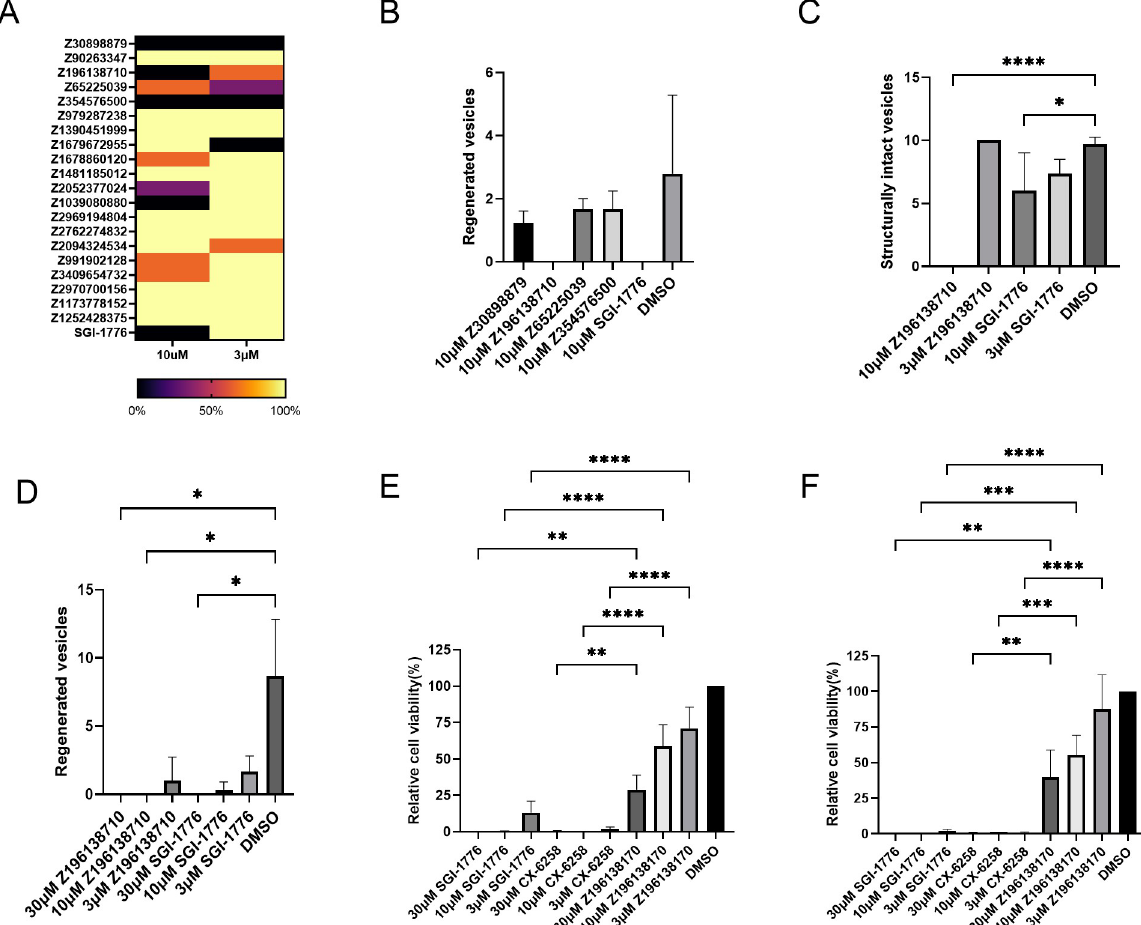
Fig 7. Effects of Pim inhibitors on Echinococcus larvae and human cells. (A) Heat map showing the effects of 20 in silico screen compounds on MV. Different concentrations (indicated below) of each compound (indicated to the left) were incubated in vitro with MV for 28 d and structural integrity was assessed. Colour-code indicating percentages of surviving vesicles is indicated below. (B) Effects of four in silico screen compounds on MV production from PC. 10 μ M of each compound (indicated below) were incubated for 21 d with PC in vitro and the production of MV was assessed. For comparison, SGI-1776 was tested at 10 μ M. Error bars represent standard deviation. Kruskal-Wallis test followed by Dunn’s multiple comparison test was used for comparisons with the control (DMSO) group. (C) Effects of Z196138710 and SGI-1776 on MV. Both compounds were tested at different concentrations (shown below) on MV in vitro . Structural integrity was measured after 28 d. Error bar represents standard deviation. One was ANOVA followed by Dunnet’s multiple comparison test was used in comparisons with control (DMSO) group. p values less than 0.0001 are summarized with ���� and p values less than 0.0332 are summarized with � . (D) Effects of Z196138710 and SGI-1776 on the in vitro formation of MV from PC. Both inhibitors were incubated at different concentrations (indicated below) for 21 d with PC and the formation of mature MV was measured. Error bar represents standard deviation. Kruskal-Wallis test followed by Dunn’s multiple comparison test was used in comparisons with control (DMSO) group. � represents p � 0.0332. (E) Effects of Z196138710, SGI-1776, and CX- 6258 on human HEK293T cells. HEK293T cells were incubated with different concentrations of inhibitors as indicated below. Cell viability was measured after 3 d. (F) Effects of inhibitors on human HepG2 cells. For experimental procedure, see (E). Error bar represents standard deviation. Tukey’s multiple comparison test followed by one way ANOVA was used to compare all experimental settings, only comparisons for equal inhibitor concentrations are shown. P values less than 0.0001 are summarized with ���� and p values less than 0.0021 are summarized with �� .